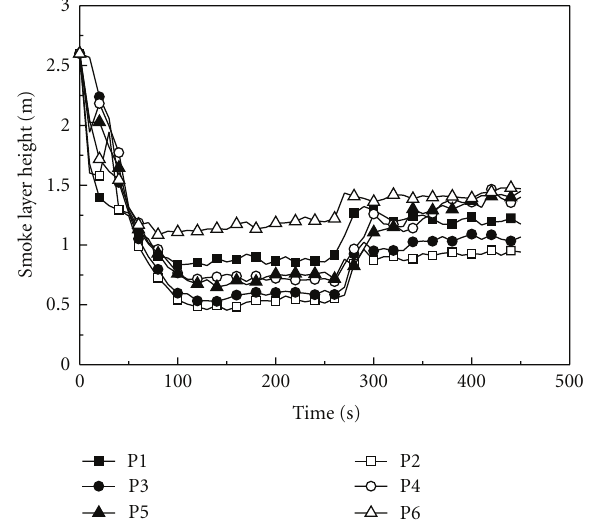
Figure 7: Smoke layer heights.